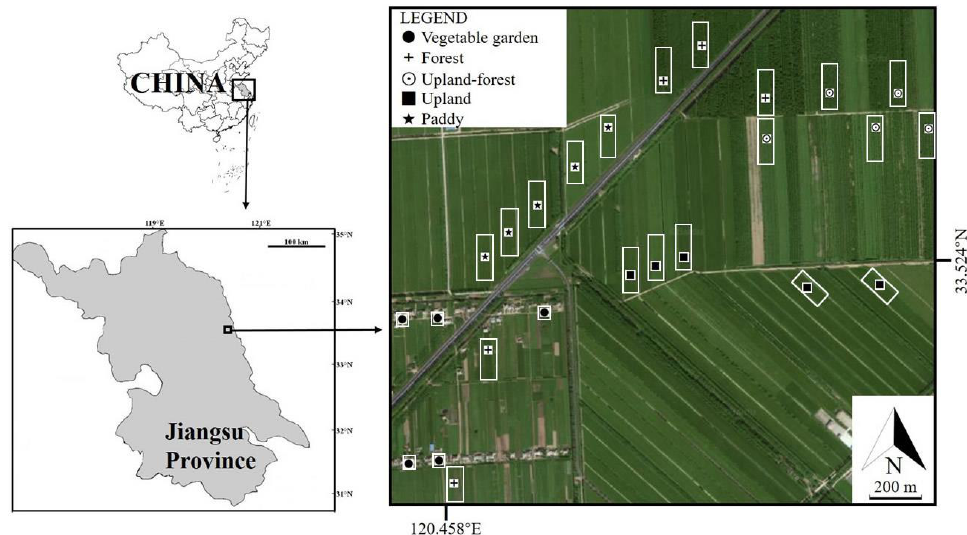
Figure 1. Sampling sites and land-use delimitation (white box) in the study area.